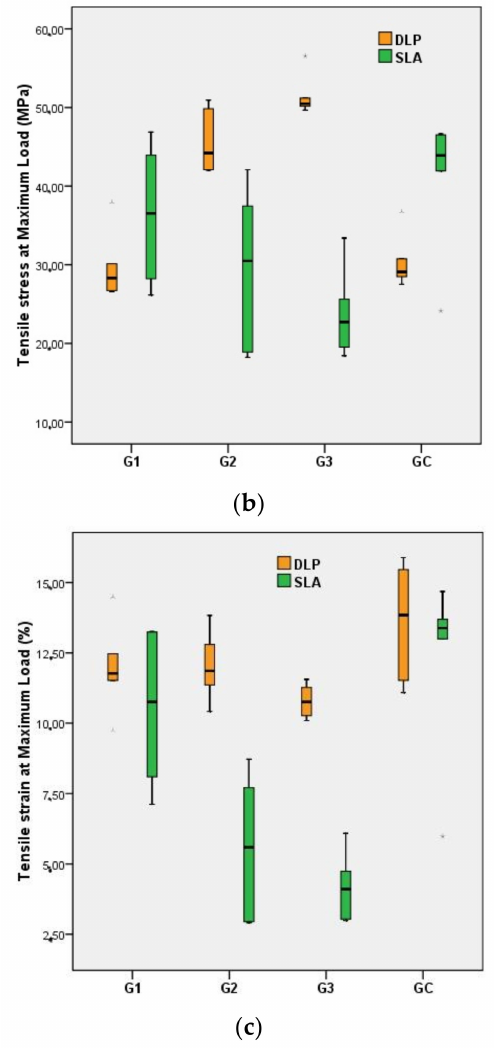
Figure 5. Boxplots of minimum, maximum, interquartile range, median, and outliers for stan- dard specimens (CG–G3) in the tensile test: tensile modulus of elasticity ( a ); tensile strength ( b ); tensile strain ( c ).